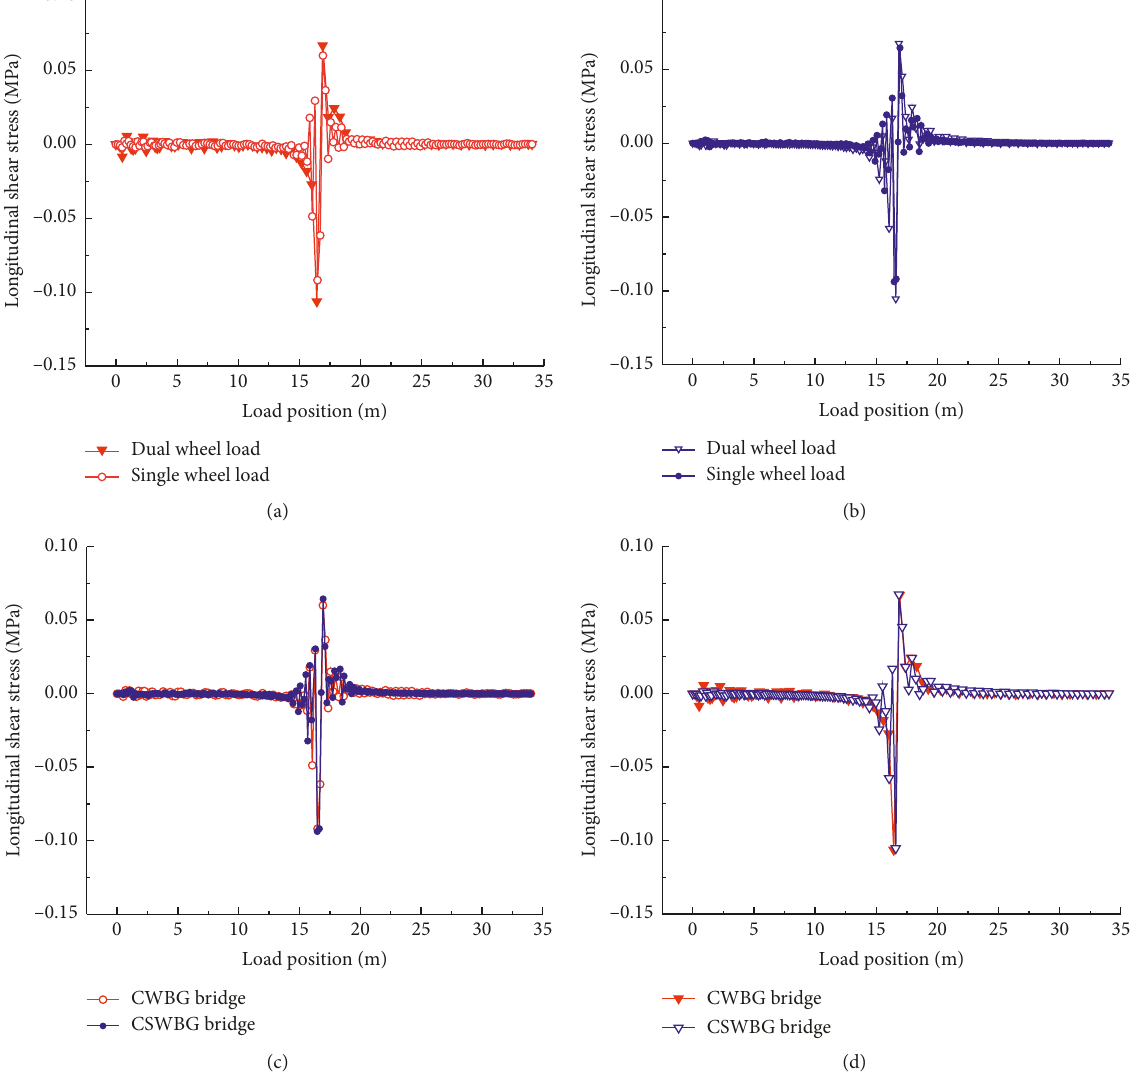
Figure 8: Comparison of longitudinal shear stress between layers of the bridge deck pavement of both models. (a) CWBG bridge. (b) CSWBG bridge. (c) Single wheel load. (d) Dual wheel